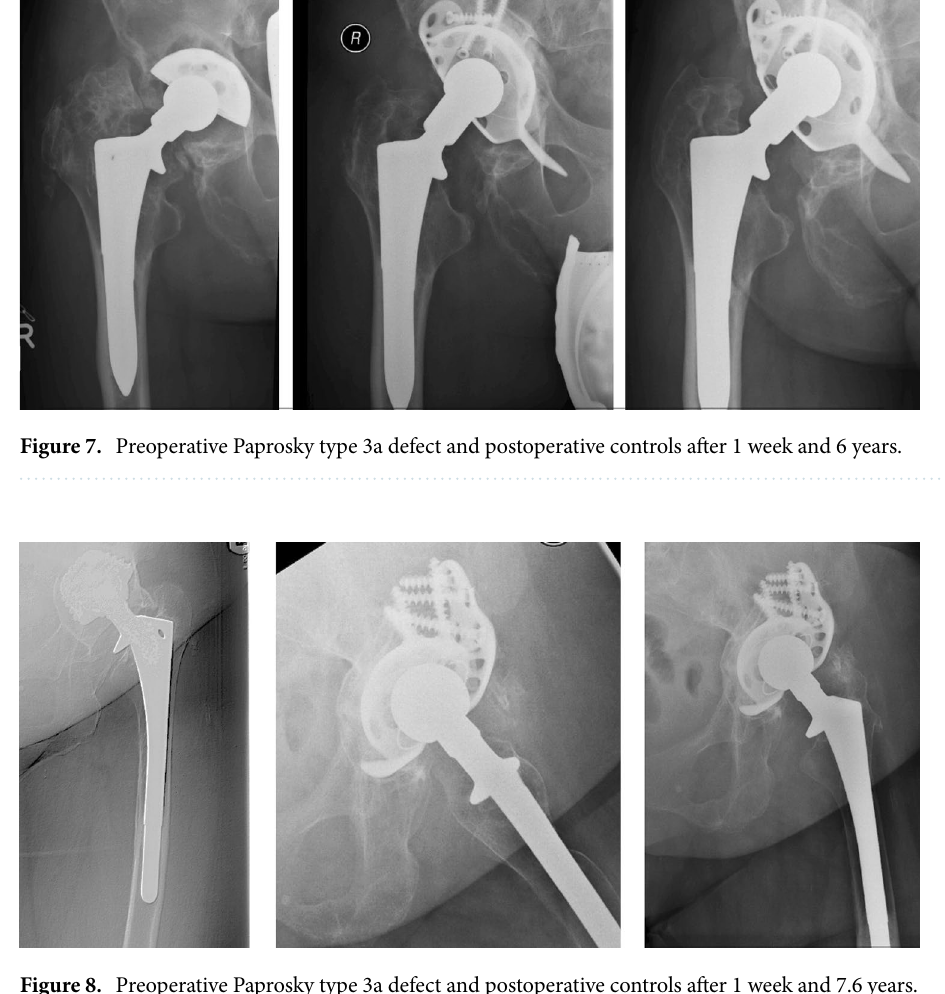
Figure 8. Preoperative Paprosky type 3a defect and postoperative controls after 1 week and 7.6 years.